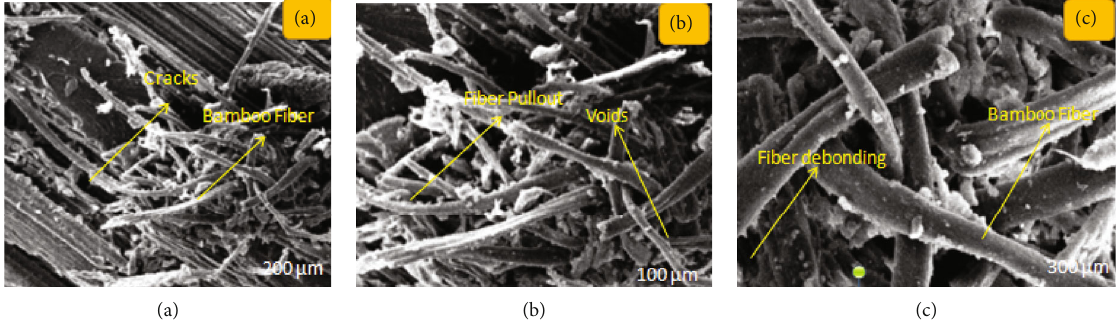
Figure 8: Micrographic images for tensile fractured surfaces of samples (a) 10% (b) 15%, and (c) 20%.